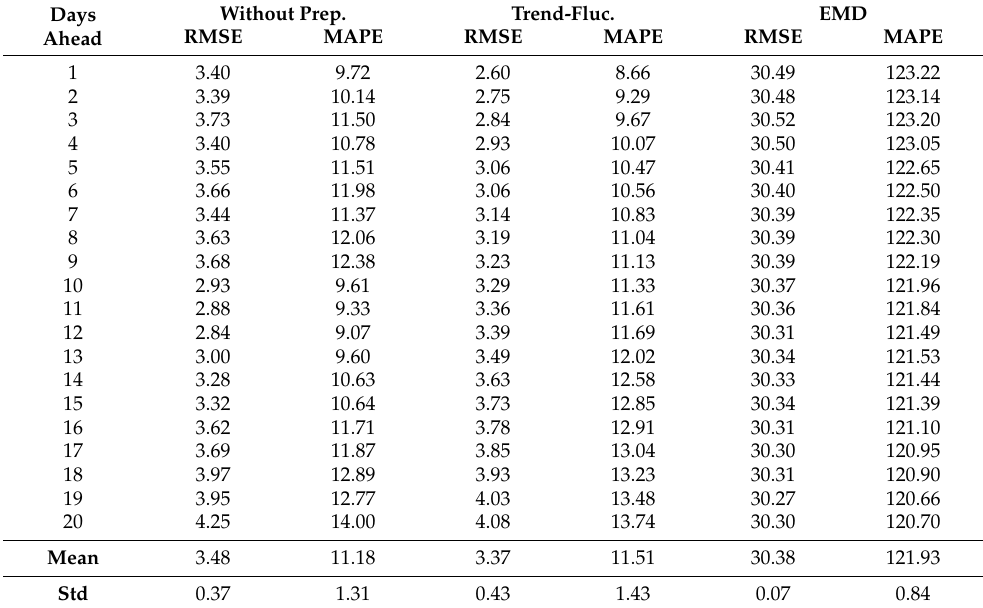
Table 8. Predictions with XGBoost for the whole data set (2009–2020). 80% of them were used for training and 20% for validation. Data have been scaled with standardization for “Without Prep.” and “Trend-Fluc.” and with Min-Max for EMD. Without Prep. Trend-Fluc. EMD Days RMSE MAPE Ahead